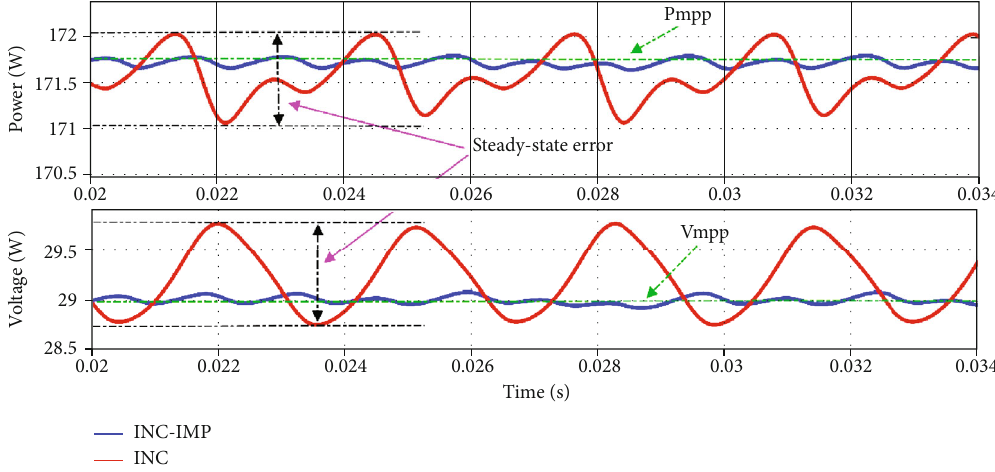
Figure 22: Comparison of the voltage and power in the steady state at G = 800W/m 2 and T = 25 ° C